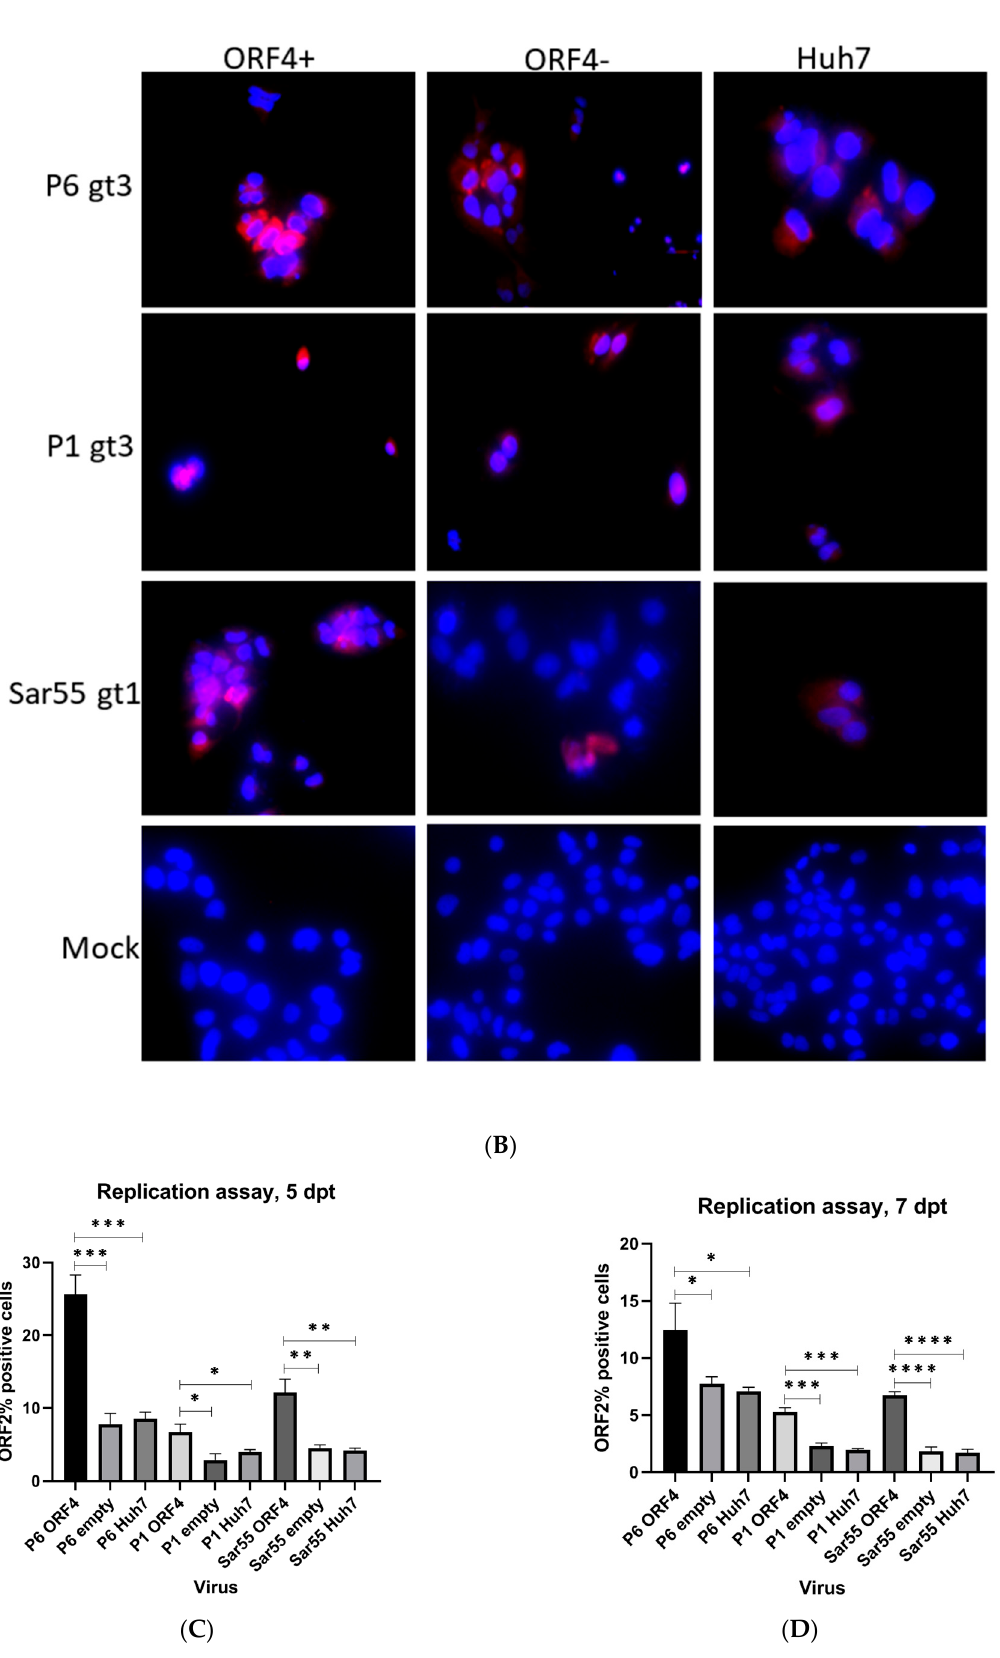
Figure 4. Presence of ORF4 from gt1 enhances the gt3 HEV and gt1 HEV replication. ( A ) Workflow of HEV transfection of target cells. ORF4+, ORF4 − and Huh7 cell lines were transfected with in vitro-transcribed capped HEV mRNA (P1, P6